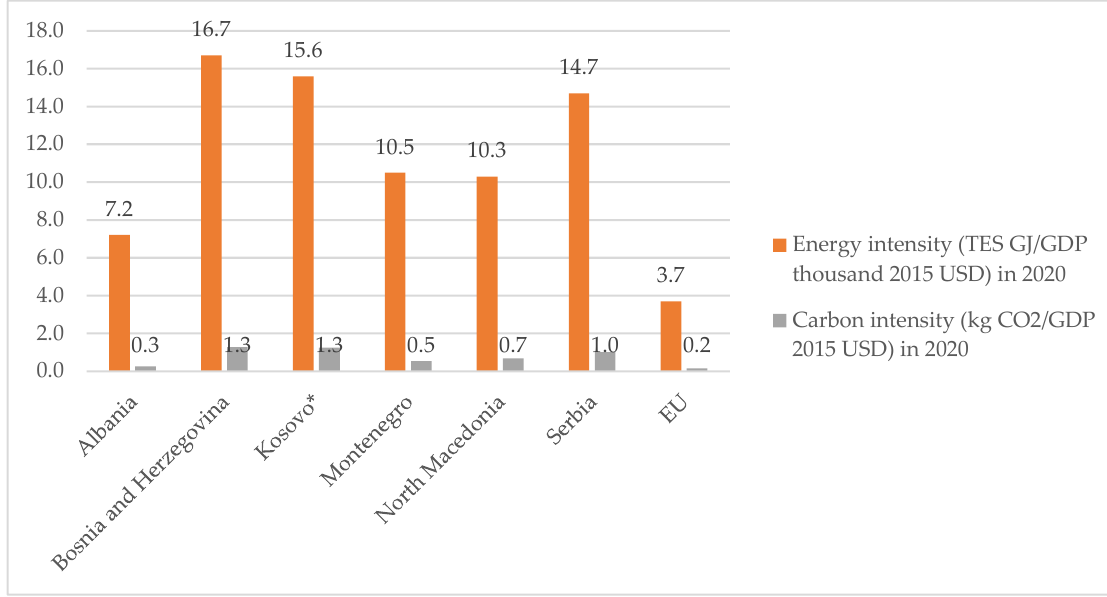
Figure 4. Energy and carbon intensity of the WB region and the EU [30].